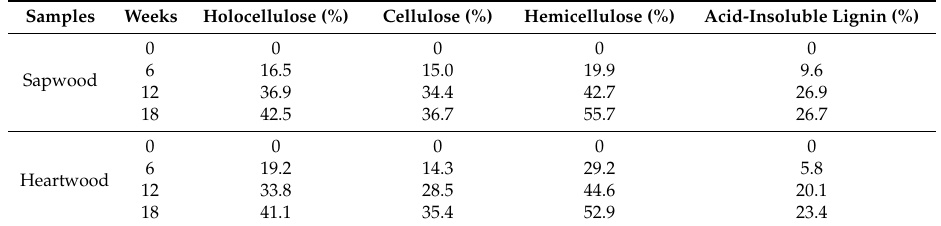
Percentage loss (%) of chemical compositions of Chinese fir following decay by Trametes versicolor (L.) Lloyd compared to individual compositions in the original oven-dried untreated